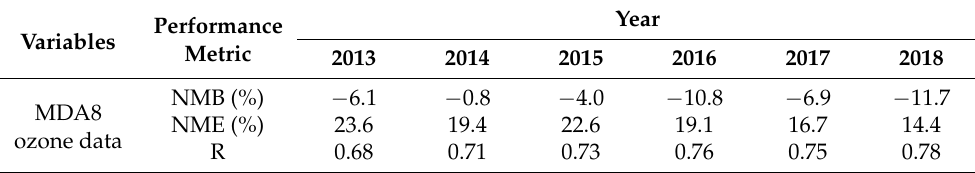
Table A3. Performance statistics of MDA8 ozone concentration simulation